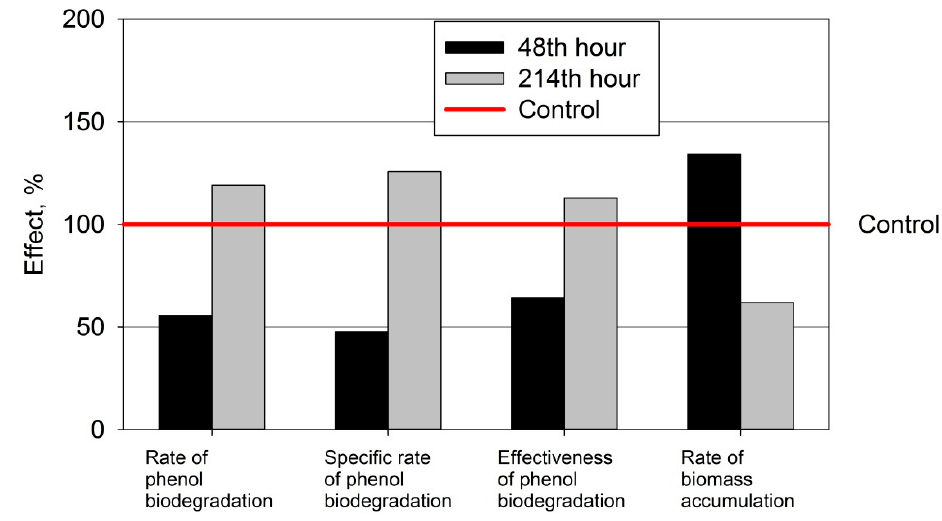
Figure 3. Effect of ND on kinetic parameters.